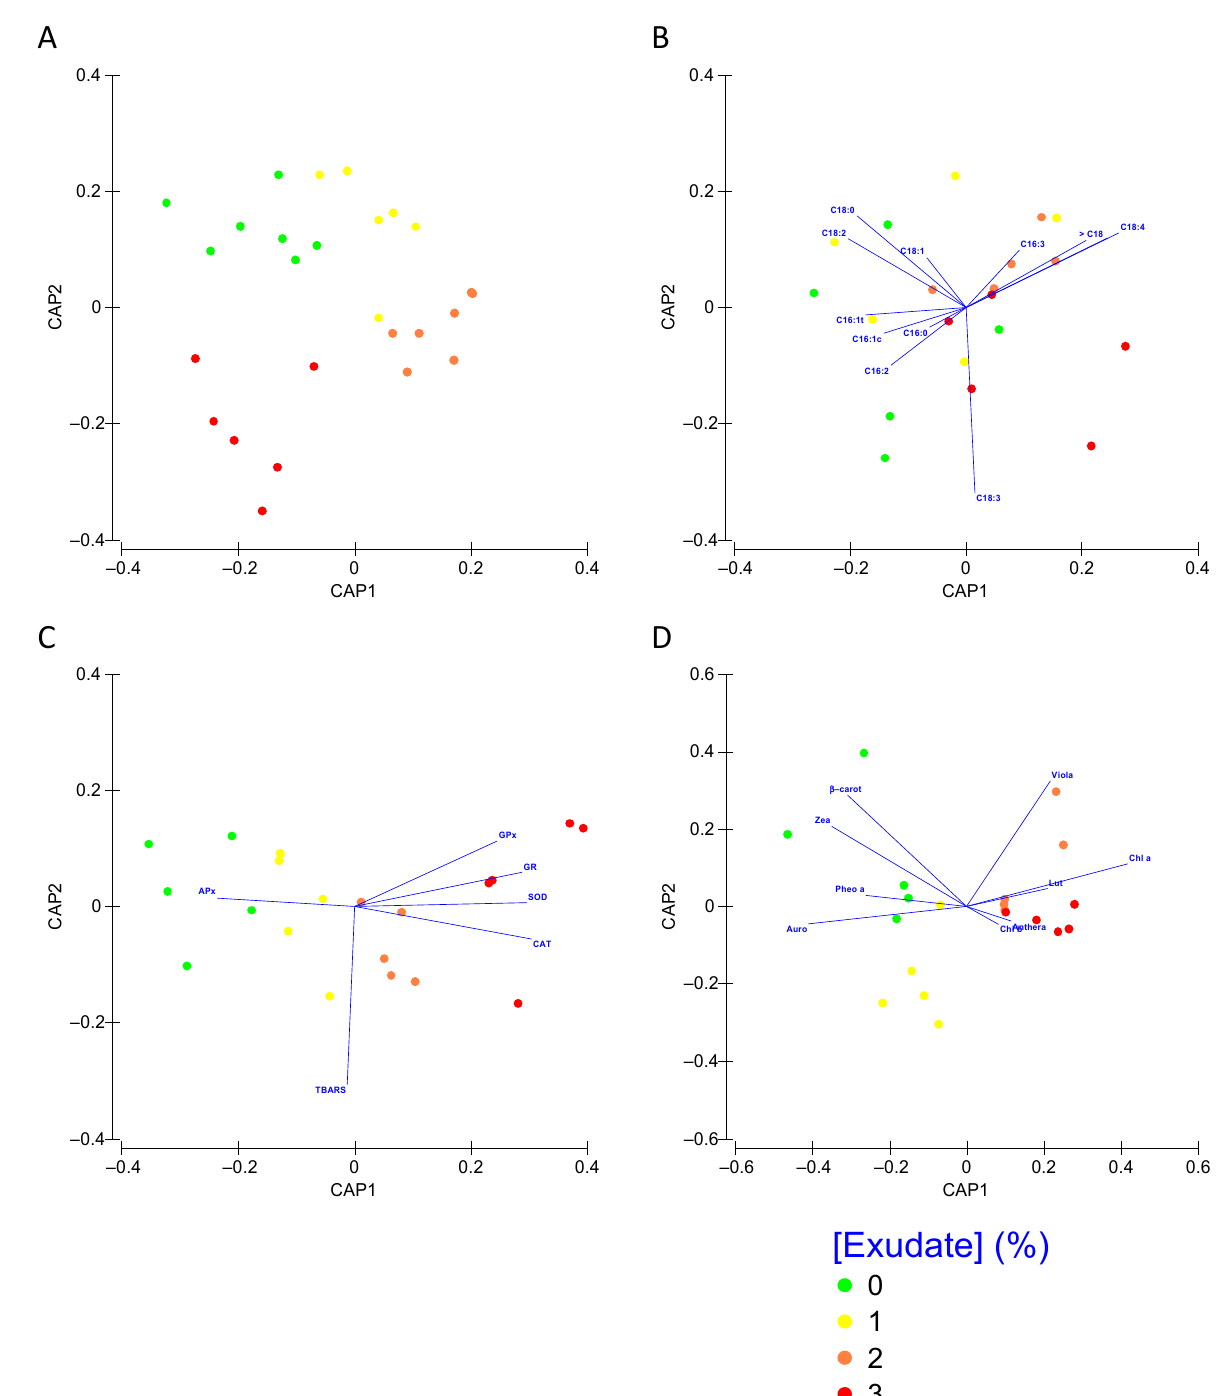
Figure 8. Thellungiella halophila photochemical ( A ), fatty acid ( B ), oxidative stress biomarkers ( C ) and pigment ( D ) profiles, assessed using multivariate Canonical Analysis of Principal Coordinates (CAP), of the plants exposed to the different Asparagopsis armata exudate concentrations tested at the end of the trial period (N = 5 per treatment).